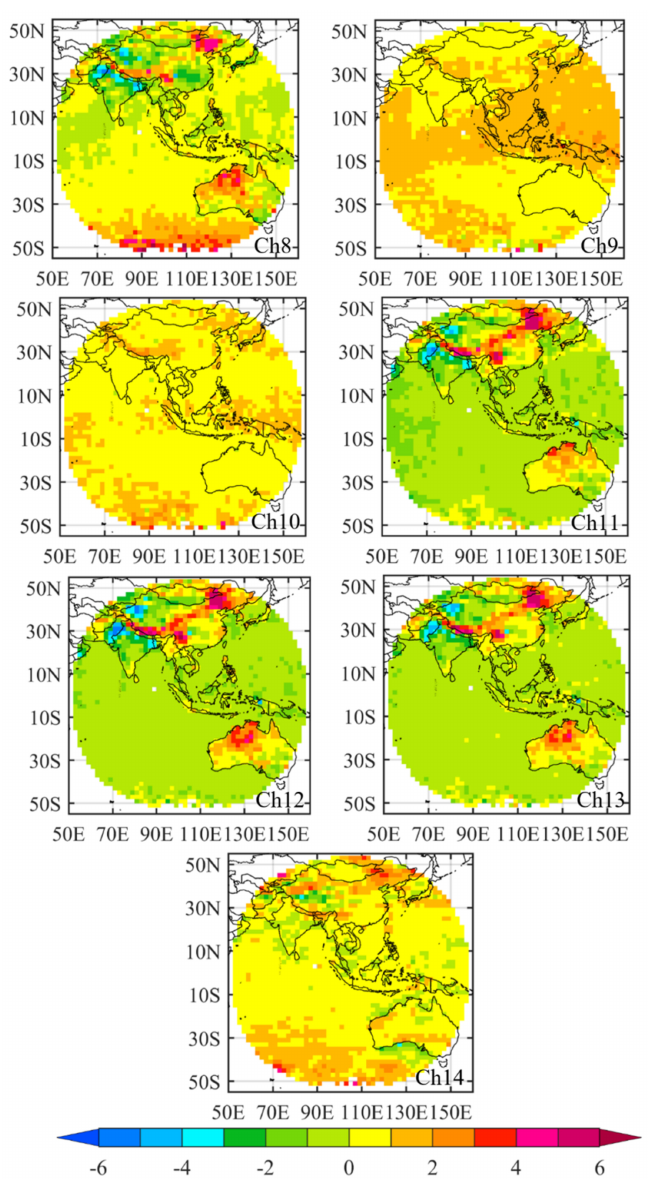
Figure 7. Spatial distributions of OMB FNL biases of AGRI bands 8–14 with satellite zenith angles less than 60 ◦ , which are calculated within each 2 ◦ × 2 ◦ grid box in January, April, July, and October 2019. (Unit: